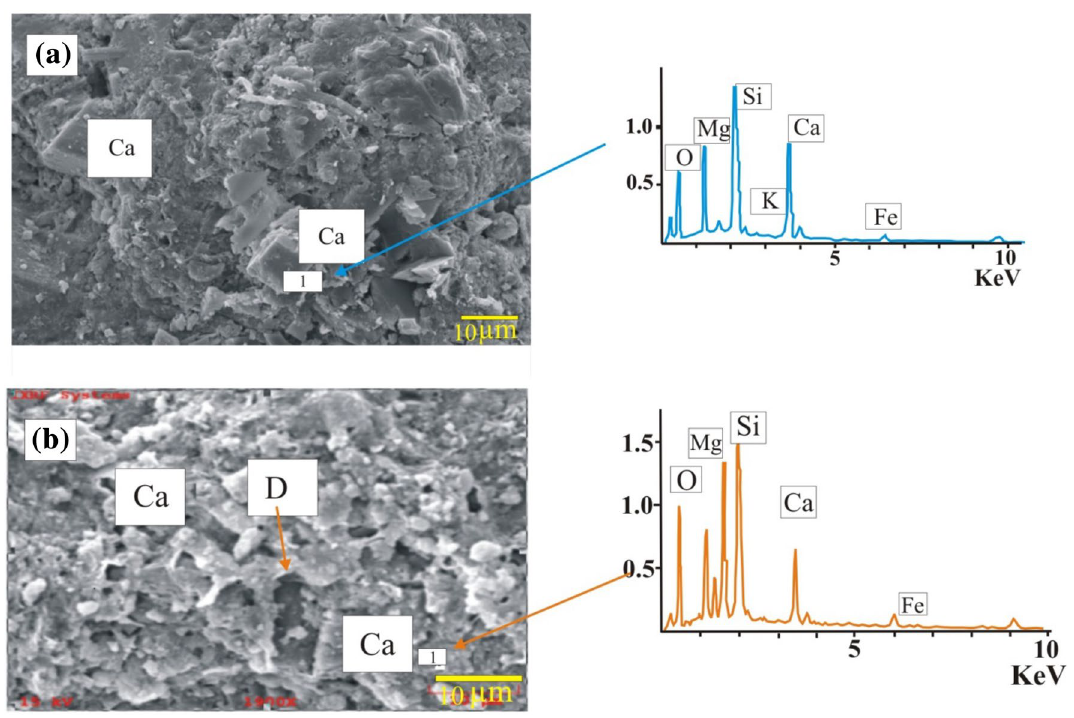
Fig. 7 Representative SEM micrographs and EDS traces for fine to medium sandstones of the Kömürlü Formation. a Early calcite min- eral (Ca) is present as a pore filling in the SEM micrographs. Dom- inant calcite (Ca) peak is seen in the EDS spectrum (a single well,